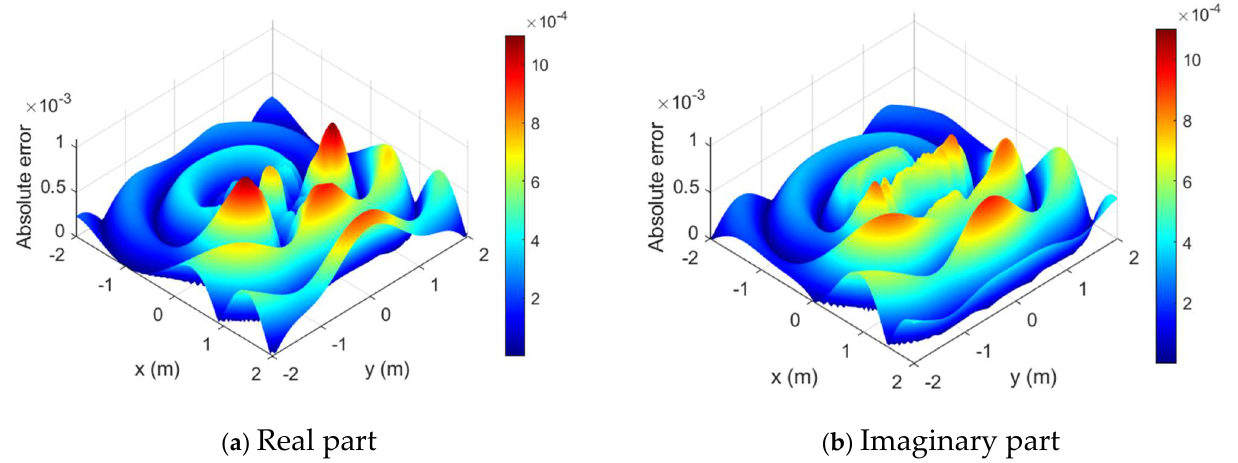
Figure 7. Analytical responses in the domain [ 2, 2] [ 2, 2]   